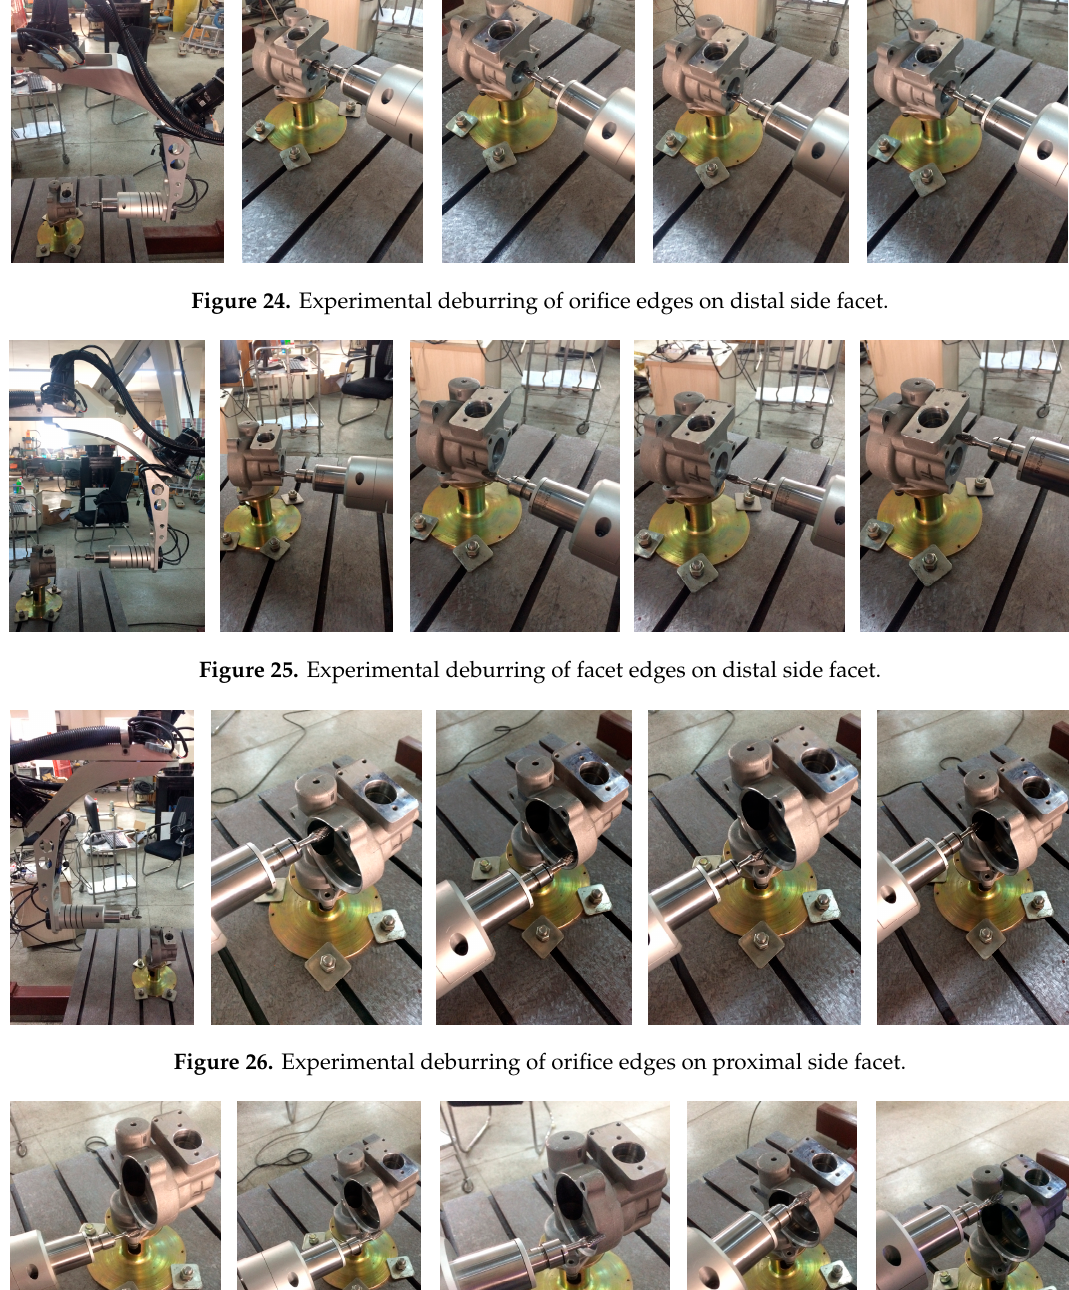
Figure 28. Experimental deburring results for multifaceted edges of automobile steering booster housing: ( a ) top facet; ( b ) distal side facet; ( c ) proximal side facet. Figure 29. Experimental deburring results of target planning path and actual tool path of top facet.